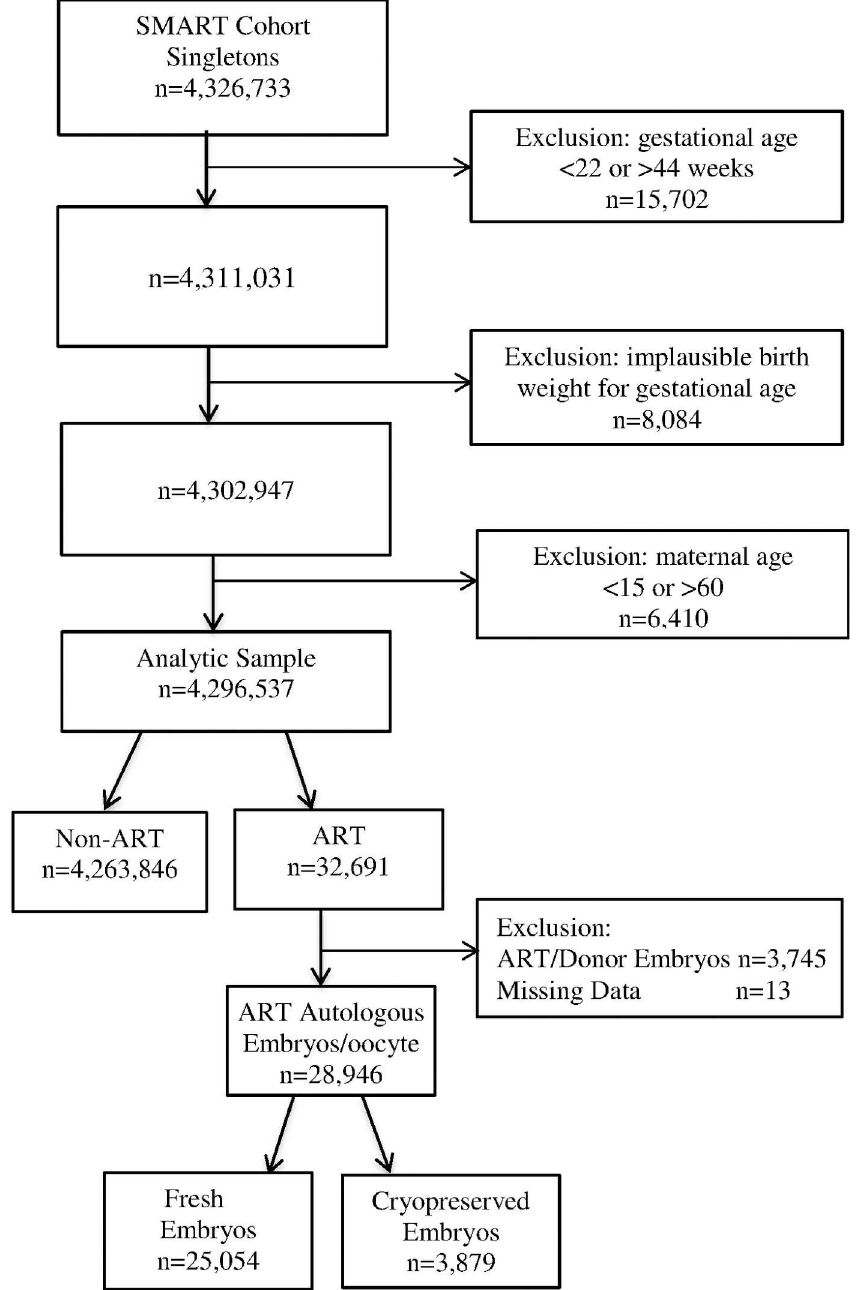
Fig 1. Flowchart of Participants in the States Monitoring Assisted Reproductive Technology (SMART) dataset: Florida and Massachusetts 2000–2010and Michigan